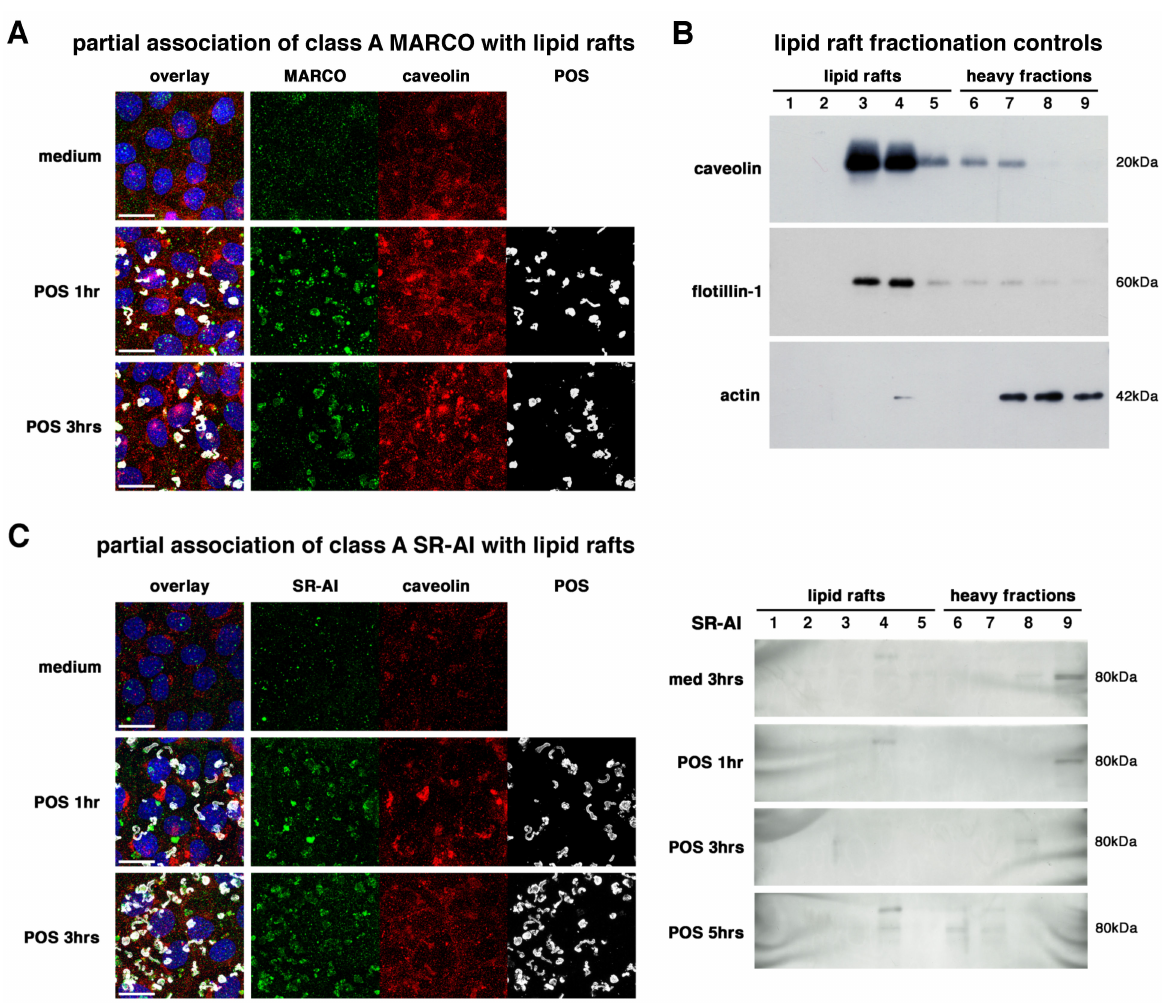
Figure 2. Partial association of class A scavenger receptors with lipid rafts. Immunocytochemistry labelings ( A , C ) show that MARCO ( A ) and SR-AI ( C ) receptors (green) partially associate with lipid rafts marker caveolin (red) after 1 (POS 1 hr) and 3 (POS 3 hrs) hours of POS (grey) challenge when compared to medium incubation as indicated. Overlay panels (left) include nuclei (blue). Scale bars: 20 µ m. Immunoblots of flotation gradient ( B , C ) fractions (1 to 9) show the proper biochemical fractionation of cells separating lipid rafts (fractions 1–5) from heavier cell parts (fractions 6–9) as assessed by specific lipid rafts markers caveolin (top) and flotillin-1 (middle), and cell cytoskeleton marker actin (bottom), as indicated ( B ). SR-AI-specific immunoblots confirm the partial association of POS and receptors to lipid rafts, especially at 3 and 5 hours (POS 3 hrs, POS 5 hrs) when compared to a 3-hour incubation with medium (med. 3 hrs), as indicated ( C